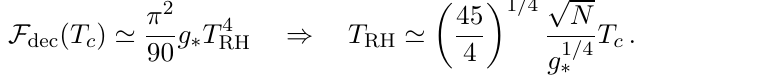
Figure 4 . Contours of (cid:1) N e , the number of efolds after the QCD phase transition, in the scenario described in section 3.1.1. We take N = 7 and N e = ln( T c = (cid:3) dec also [4{13, 25{31] for related analyses but where mainly only short eras of supercooling were